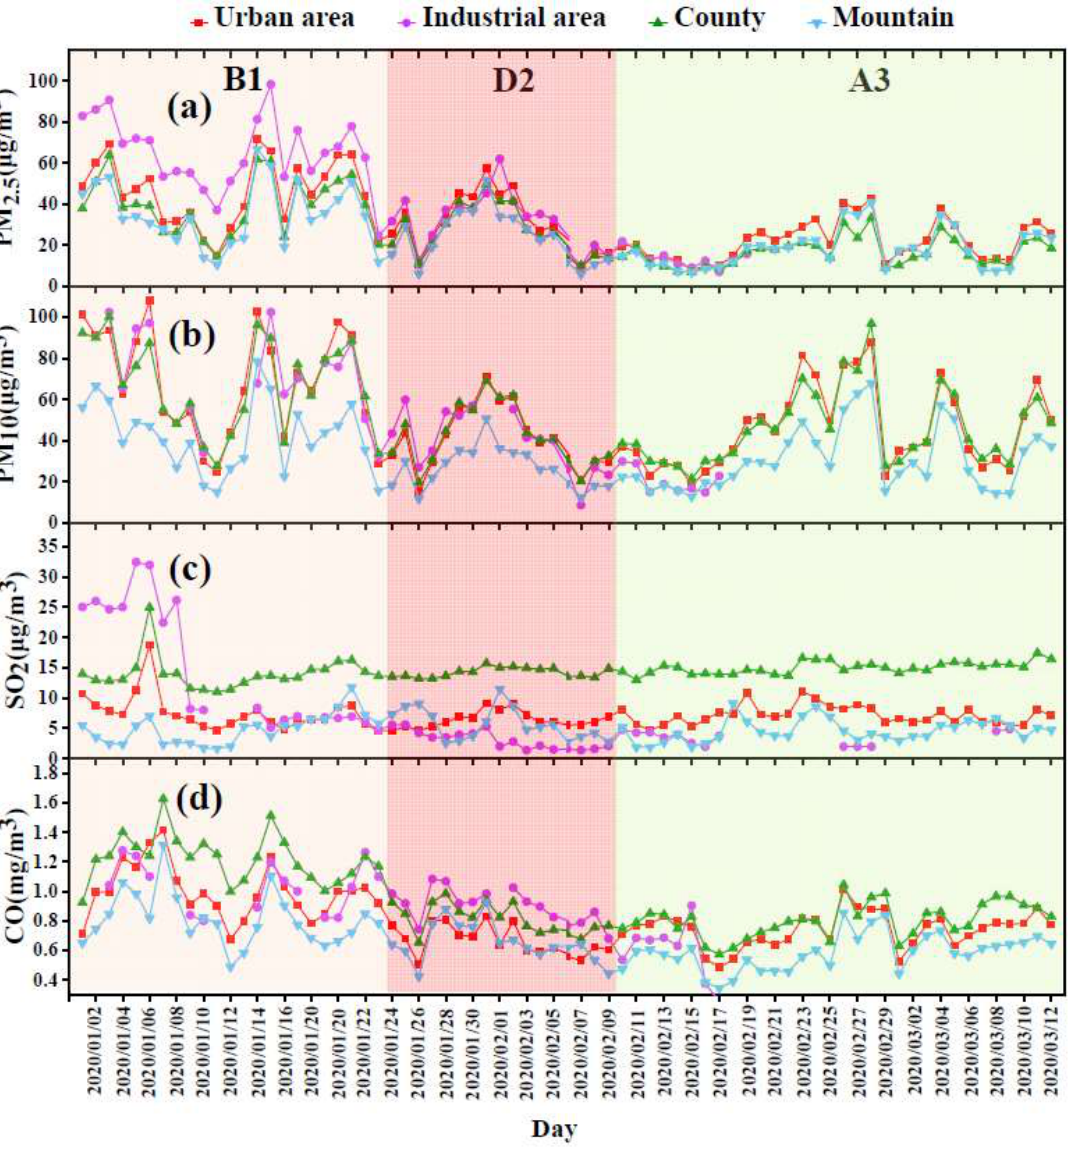
Figure 6. Daily mean concentrations of air pollutants of four regions in Nanchang from 1 January to 12 March 2020: ( a ) PM 2.5 ; ( b ) PM 10 ; ( c ) SO 2 ; ( d )